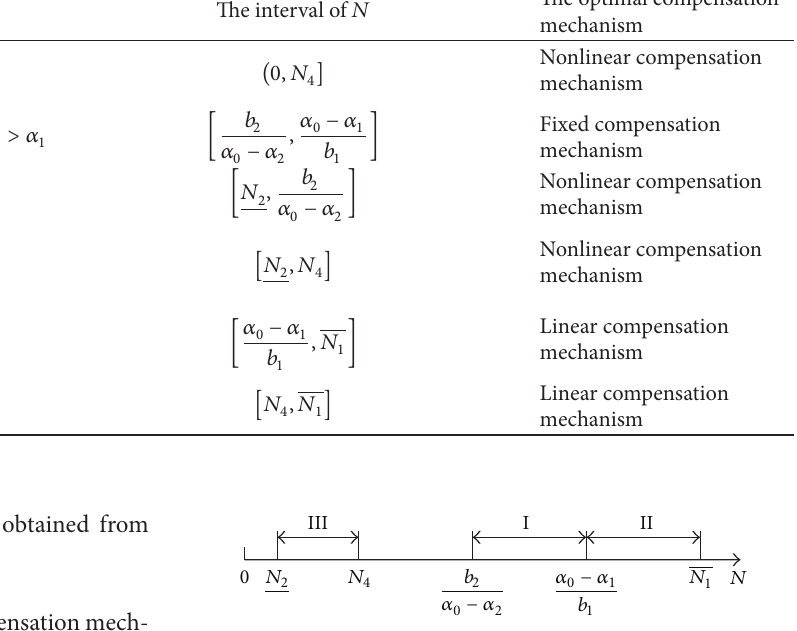
Figure 2: The optimal compensation mechanism in different inter-